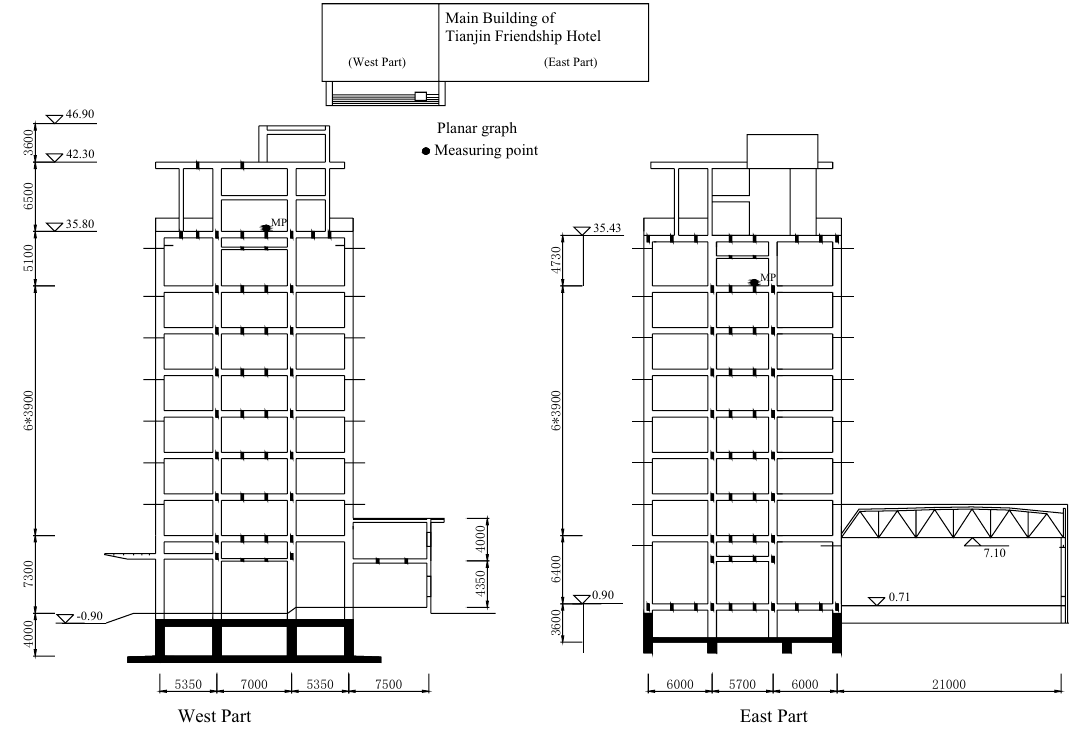
Figure 4. Section and measuring point layout of the building B.